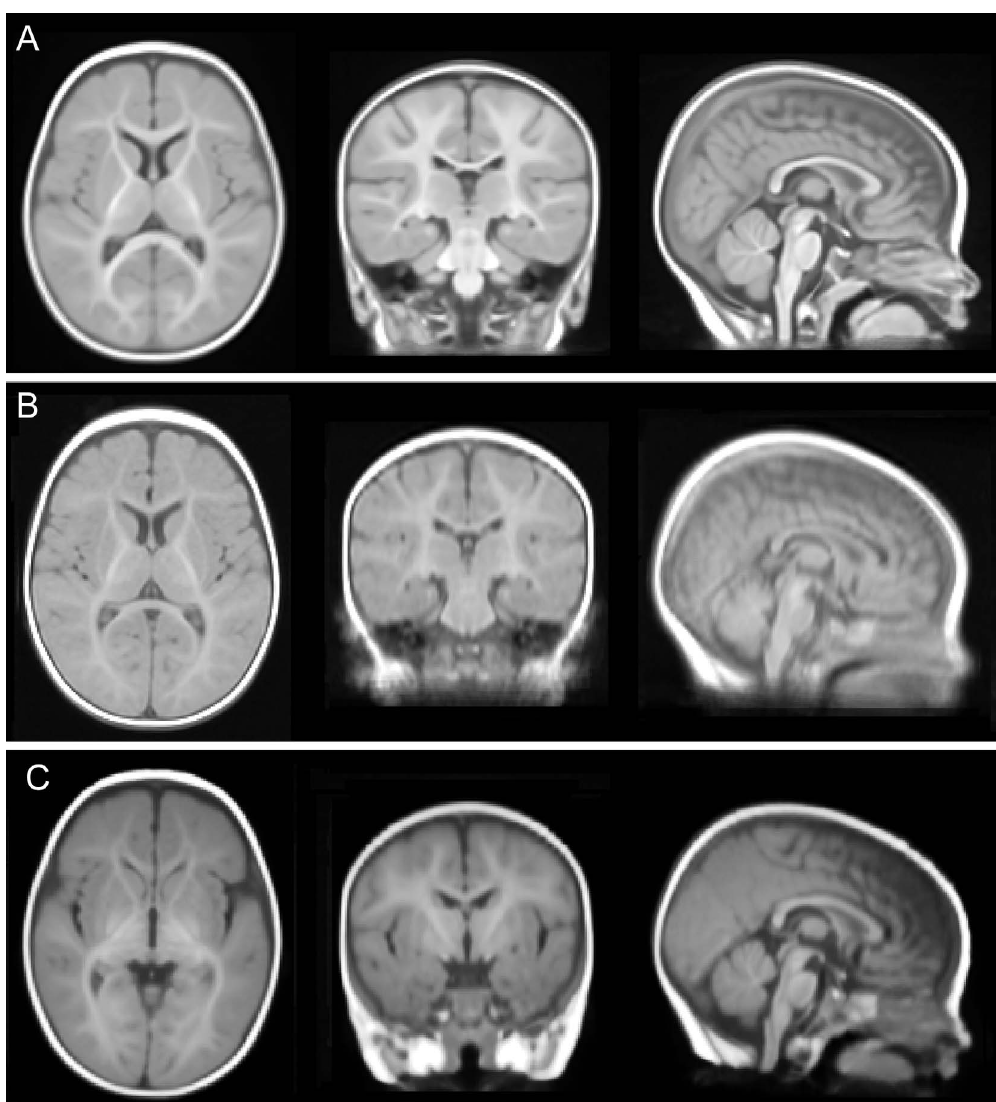
Figure 4. Comparison of average head templates. A qualitative comparison of (A) the new combined age-specific 6-month-old infant average template, (B) Fonov et al. NIHPD5–8m template for ages 5–8 months [2] and (C) Sanchez et al. 6-month-old average template [25]. Sagittal, coronal and axial slices are shown at (97, 116, 79). Not to scale, see Table 2 for measurements.